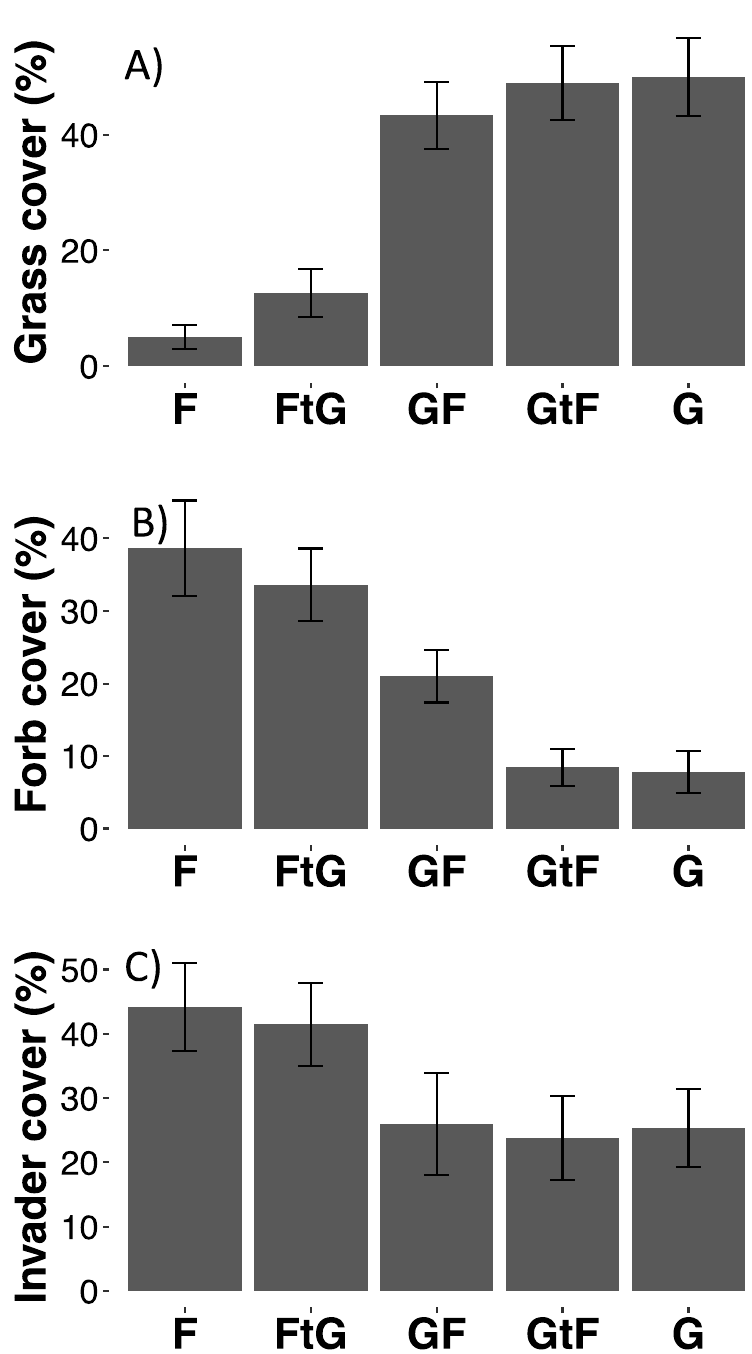
Figure 1. Mean cover ( ± standard error) of ( A ) native grasses, ( B ) native forbs, ( C ) exotic plants across priority planting treatments including forbs seeded alone (F), forbs seeded a year before grass (FtG), grasses and forbs seeded at the same time (GF), grasses seeded a year before forbs (GtF), and grasses seeded alone (G).